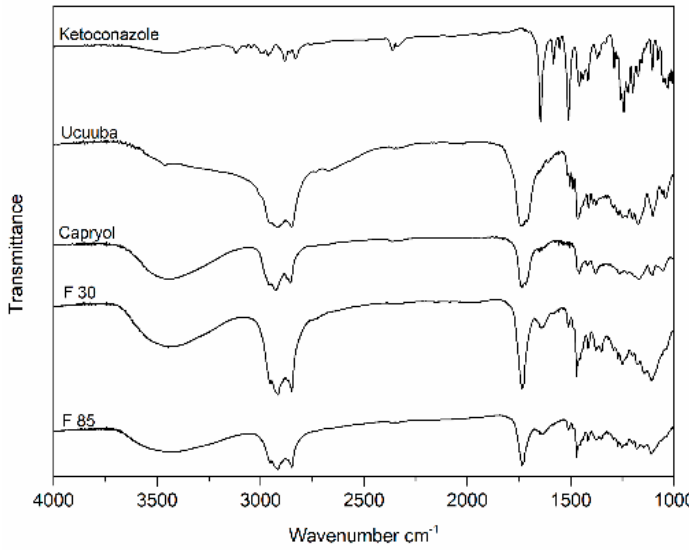
Figure 9. FT-IR spectra of ketoconazole, Ucuùba fat, Capryol™ 90 and of optimized Ucuùba fat NLC formulations F 30 and F 85.